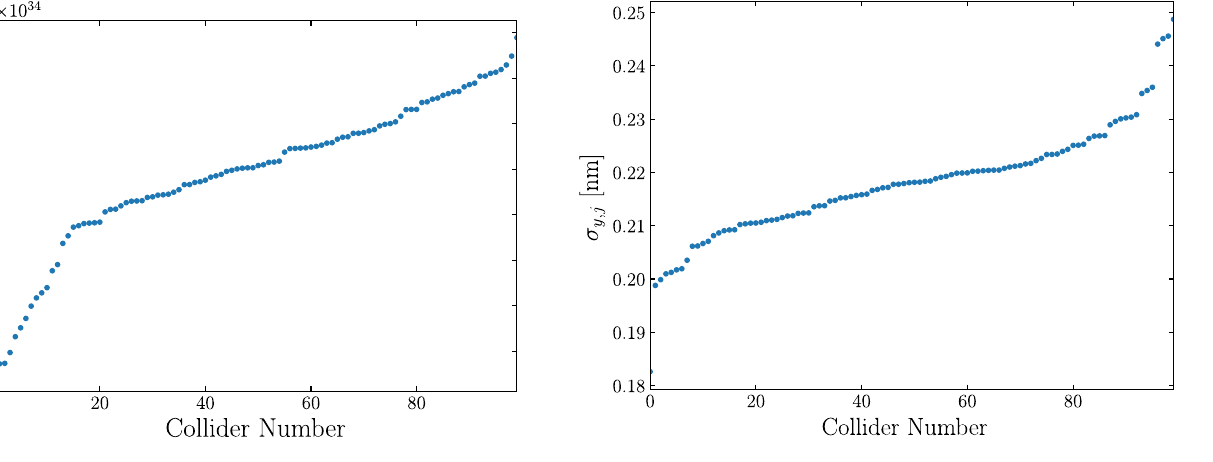
FIG. 7. Luminosity L vs collider number for 100 tuned colliders with static imperfections. Colliders are ordered in ascending luminosity.